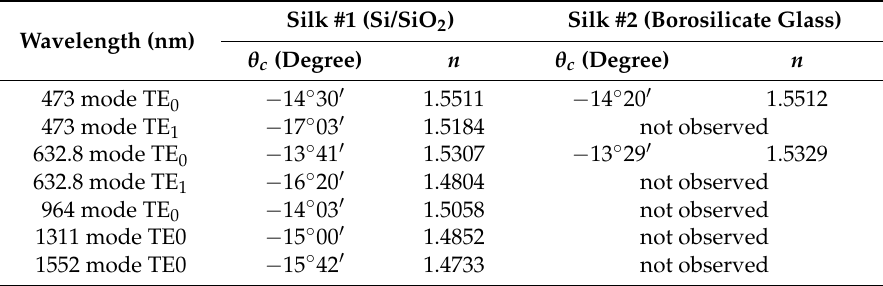
Table 3. The evaluation of silk refractive indices. The waveguiding properties of the deposited silk layer: the angle of incidence of the TE modes.